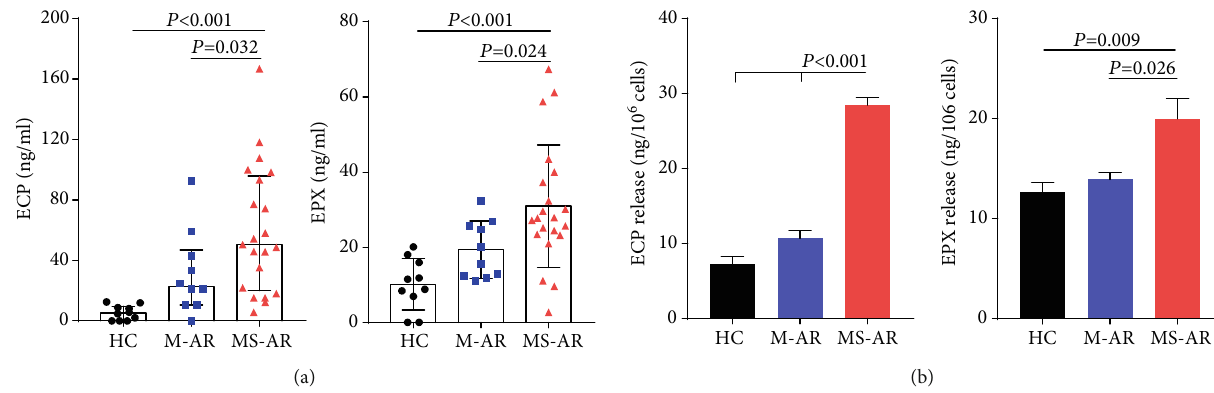
Figure 5: Blood eosinophils from subjects with moderate-severe allergic rhinitis produce more granule proteins. (a) Serum ECP and EPX levels in healthy controls, mild allergic rhinitis, and moderate-severe allergic rhinitis. (b) ECP and EPX release from blood eosinophils induced by CCL11. ECP: eosinophil cationic protein; EPX: eosinophil peroxidase; HC: healthy controls; M-AR: mild allergic rhinitis; MS- AR: moderate-severe allergic rhinitis. Table 4: Demographic summary of subjects used in the in vitro eosinophil function study.